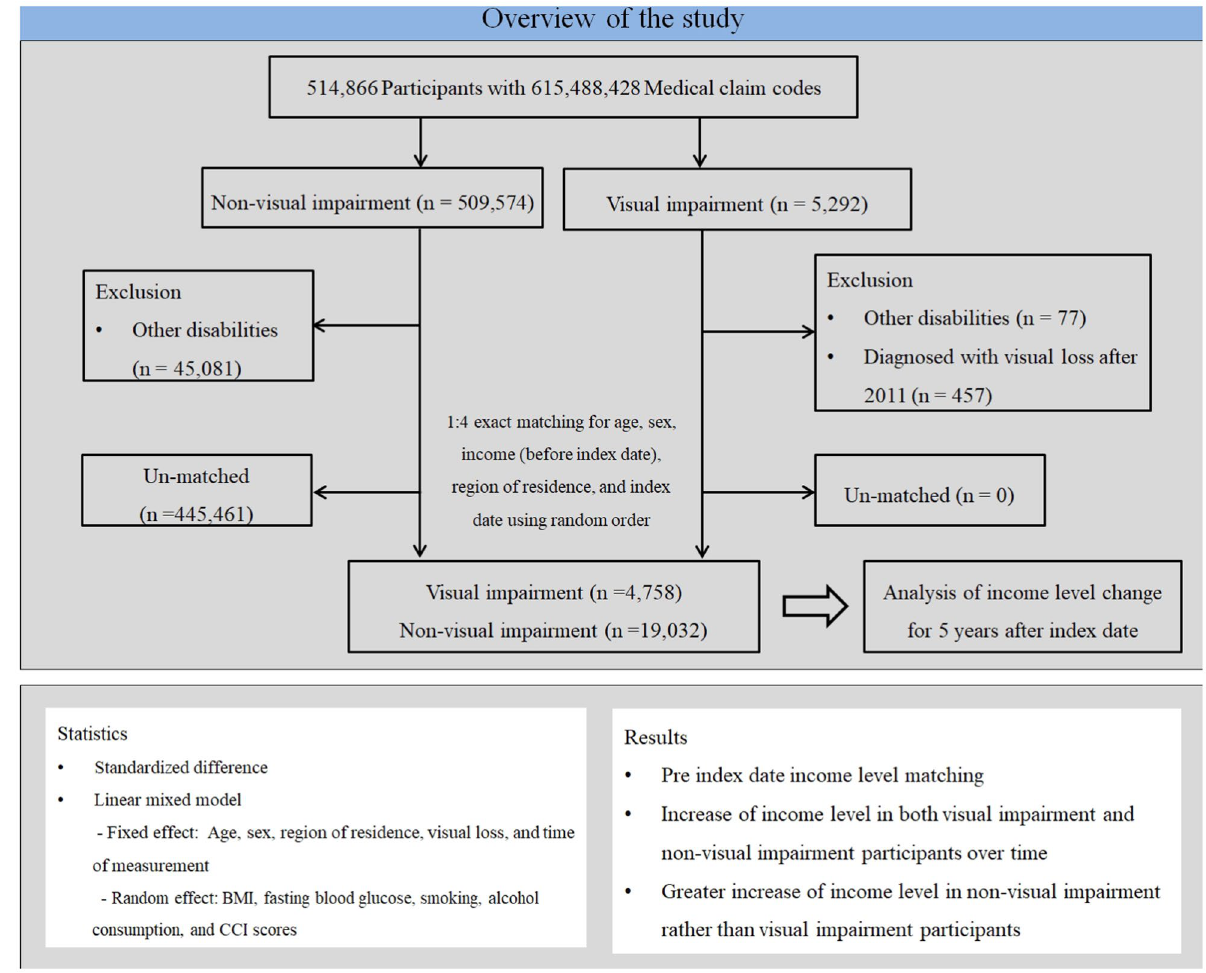
Figure 1. Schematic illustration of participant selection process used in present study. Among a total of 514,866 participants, 4758 visual impairment (VI) participants were 1:4 matched with 19,032 non-VI participants for age, sex, income level, and region of